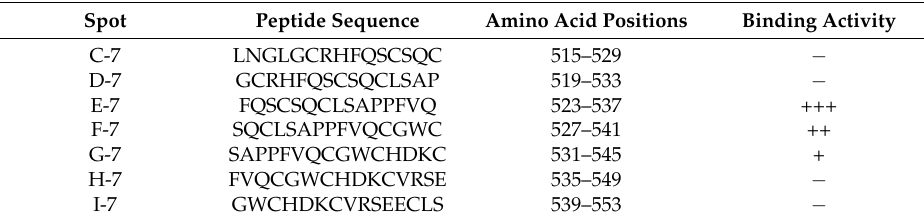
Table 2. Summary of epitope